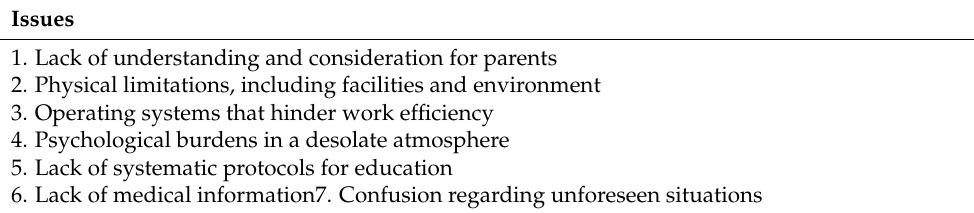
Table 2. Seven issue types in NICU parental